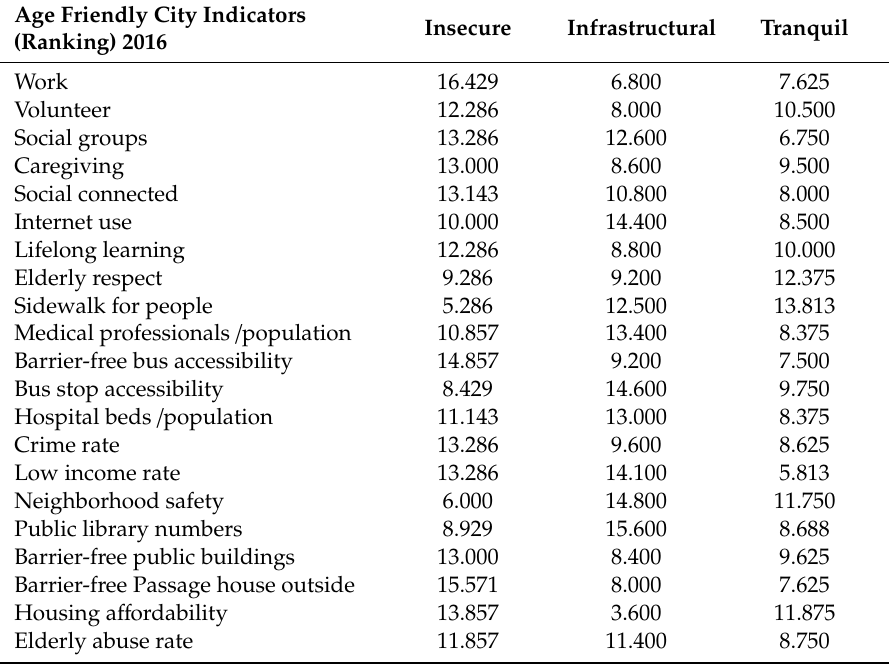
Table 3. City clusters of age friendly city indicators.